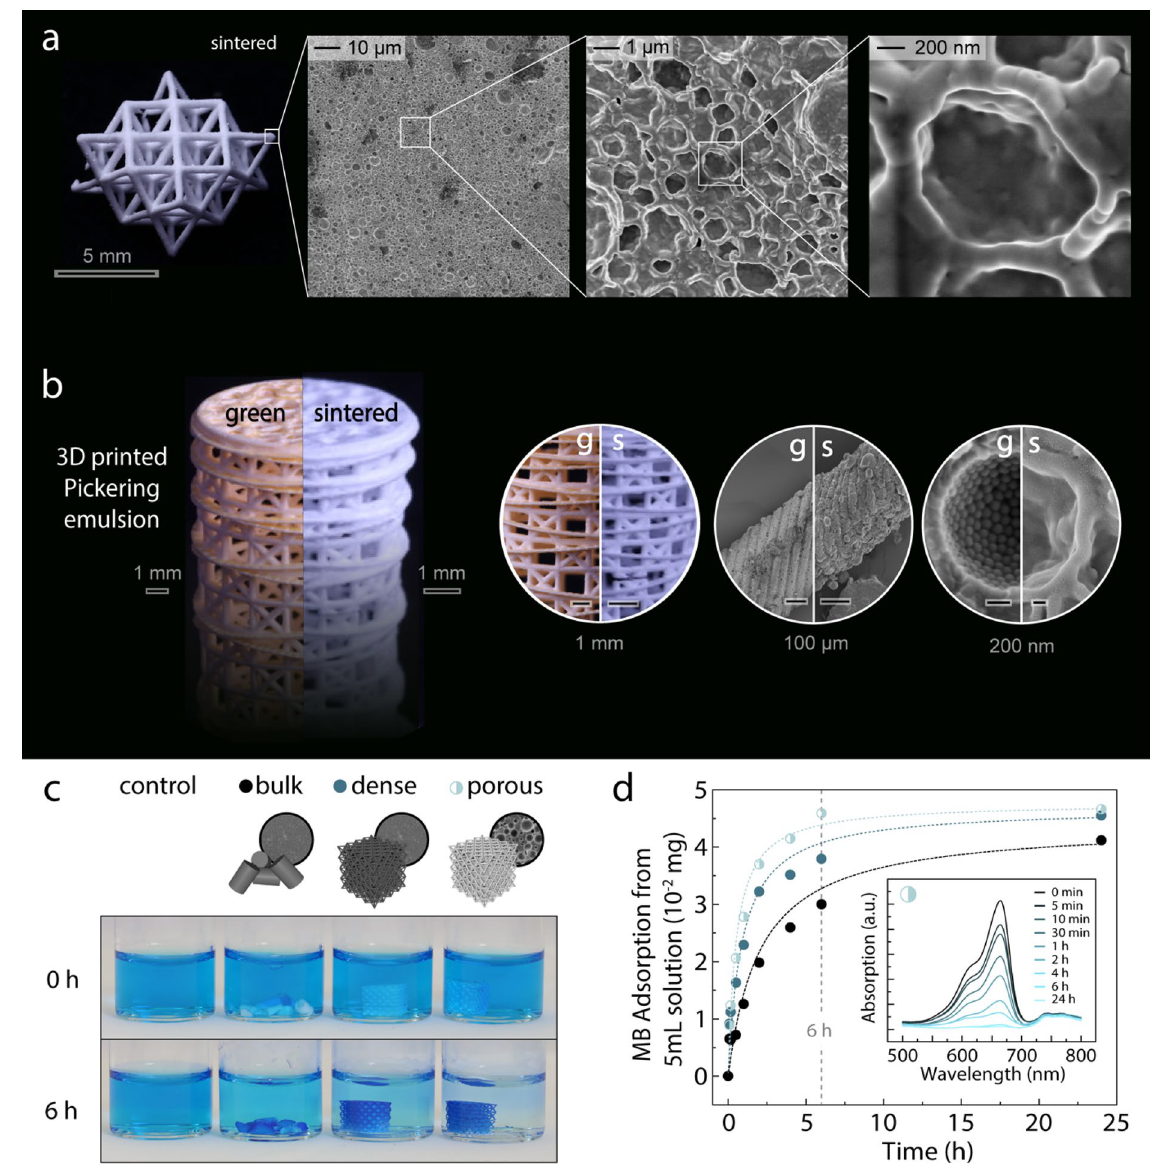
Figure 4. Hierarchical silica structures obtained upon heat treatment of as-printed composites. ( a ) Octet lattice with microporous silica struts. SEM images of the struts reveal that sintering of the silica nanoparticles at high temperatures result in high shape retention also in the microstructure. ( b ) Complex hierarchical structures fabricated via 3D printing of Pickering emulsions. ( c , d ) Adsorption measurements of the bulk ceramic and octet lattices with dense and microporous struts using a 10 mg/L aqueous methylene blue (MB) solution. The UV–Vis measurements ( d ) show that the octet lattice with microporous struts shows an adsorption rate that is a factor eight faster than the bulk ceramic. The dashed lines correspond to a theoretical fitting using a pseudo- second order adsorption kinetics model 35 . The inset in ( d ) shows the evolution of the absorption spectra of MB aqueous solution exposed to the octet lattice with microporous strut over a period of 24